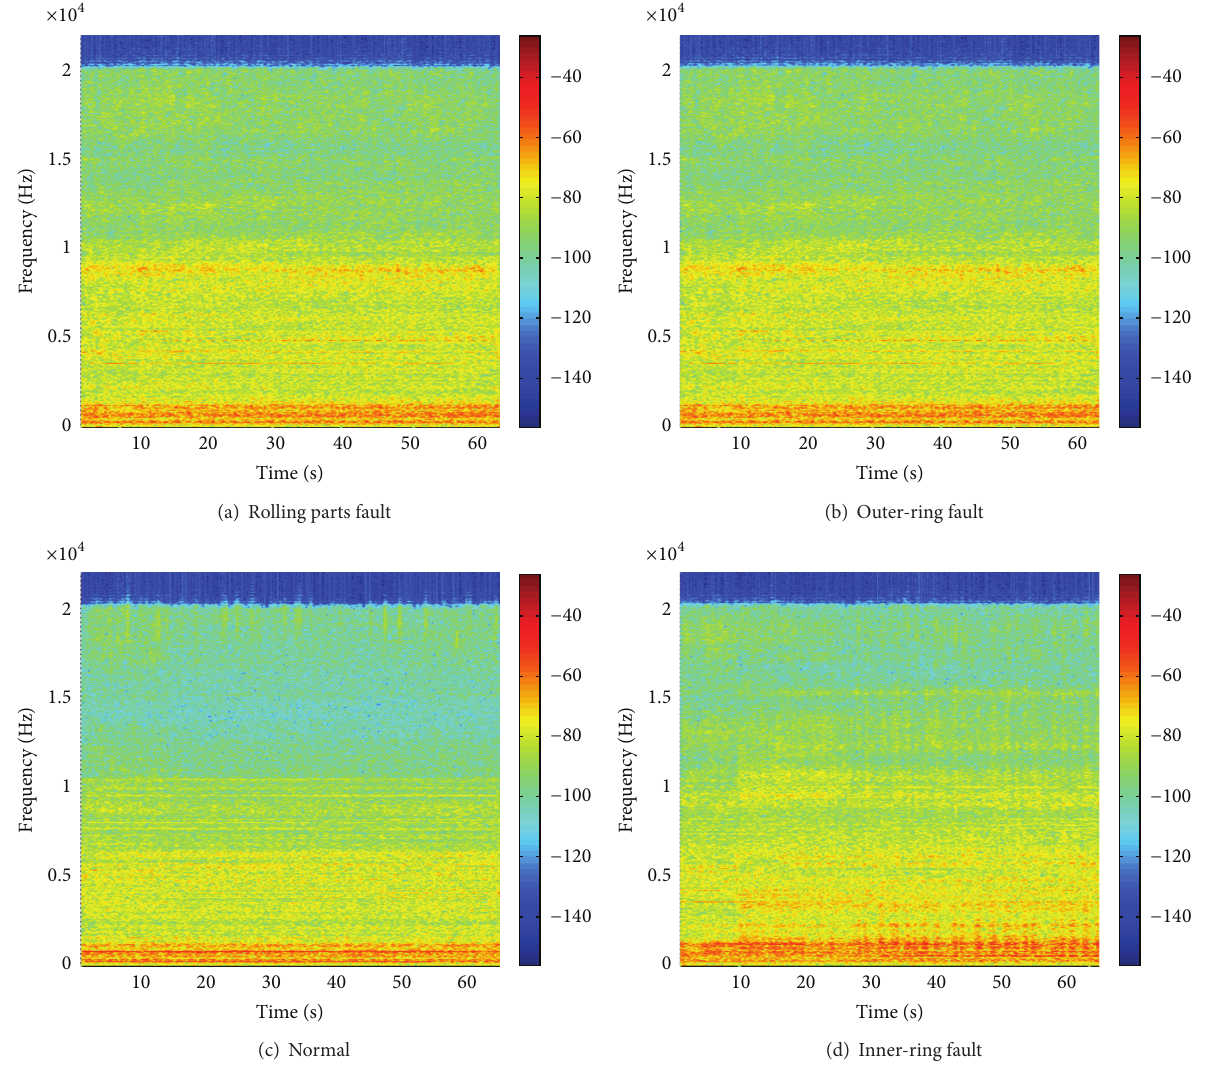
Figure 13: Spectrograms of the four fault modes. Table 4: Data information.